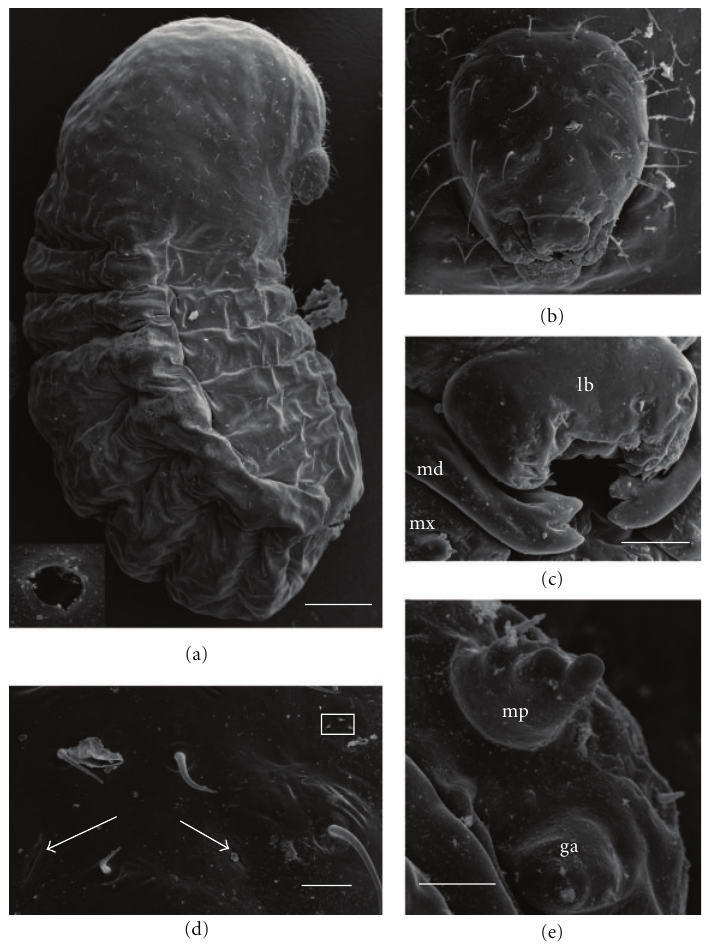
Figure 6: Last instar larva of male of Solenopsis saevissima . (a) Body in side view. (b) Head capsule in full frontal view. (c) Mouthparts in oblique view; lb: labrum; mx: maxilla; md: mandible. (d) Detail on frons of head capsule; arrows: tentorial pits; white box: left antenna. (e) Detail on right maxilla, showing maxillary palp (mp) and galea (ga). Respective sizes of scale bars ( µ m): 400, 100, 20, 30, and